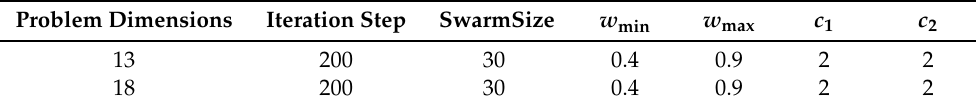
Table 4. Main parameters of the AMPSO algorithm.